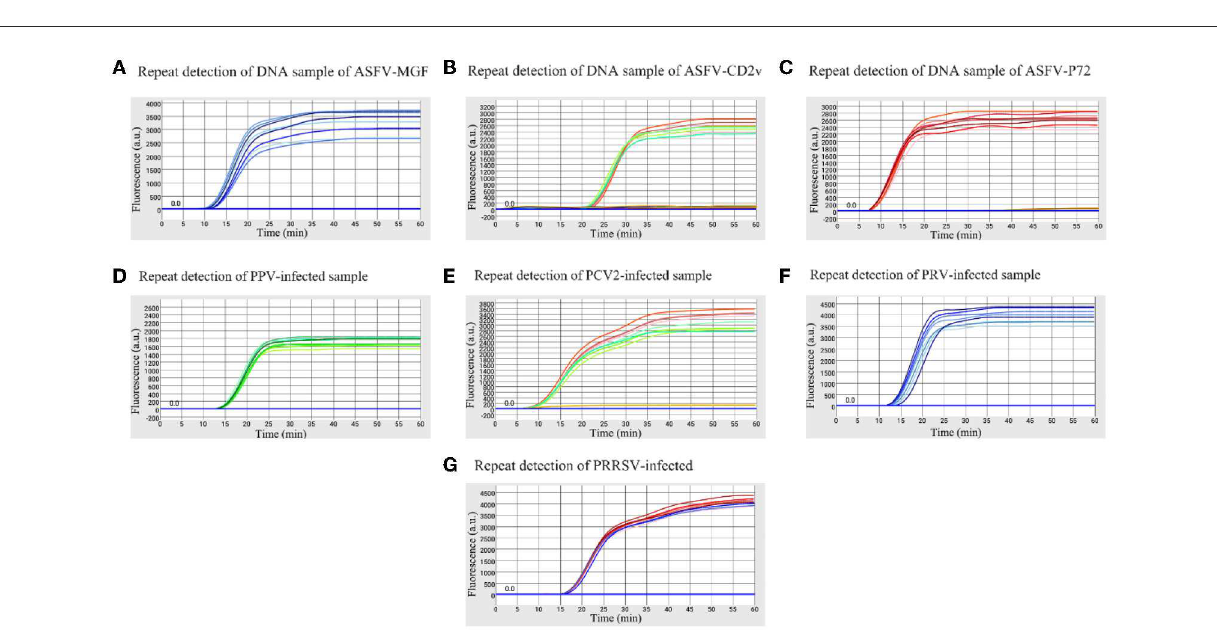
FIGURE6 Reproducibility of the microfluidic-LAMP chip detection system for five swine pathogens. (A–C) Stability test of ASFV-MGF, ASFV- CD2v , and ASFV- P72 for eight replicate experiments using a DNA sample. (D–G) Stability test of PRV, PPV, PCV-2, and PRRSV for eight replicate experiments using a clinical virus-infected